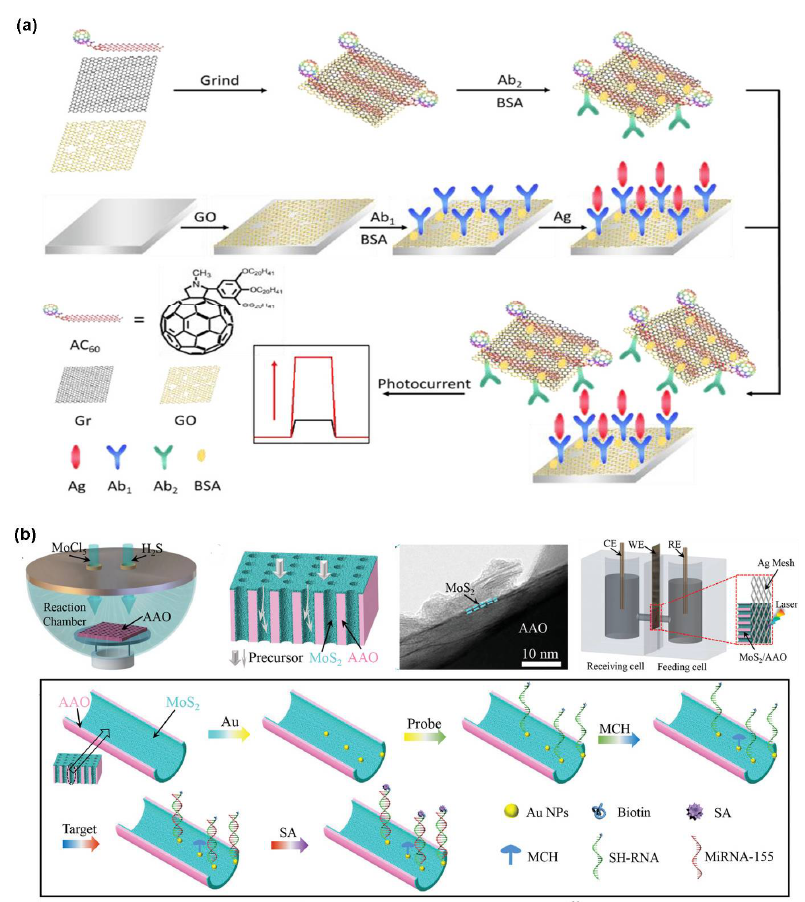
Figure 4. ( a ) Scheme of general processes for the assembly of AC 60 -Gr-GO and construction of the PEC AFP immunosensor. Adapted with permission from ref. [95]. Copyright 2018, American Chemical Society; ( b ) schematic illustration of the construction of a PEC biosensor based on the MoS 2 /AAO photoactive nanochannel. Adapted with permission from ref. [106]. Copyright 2020, John Wiley and Sons.